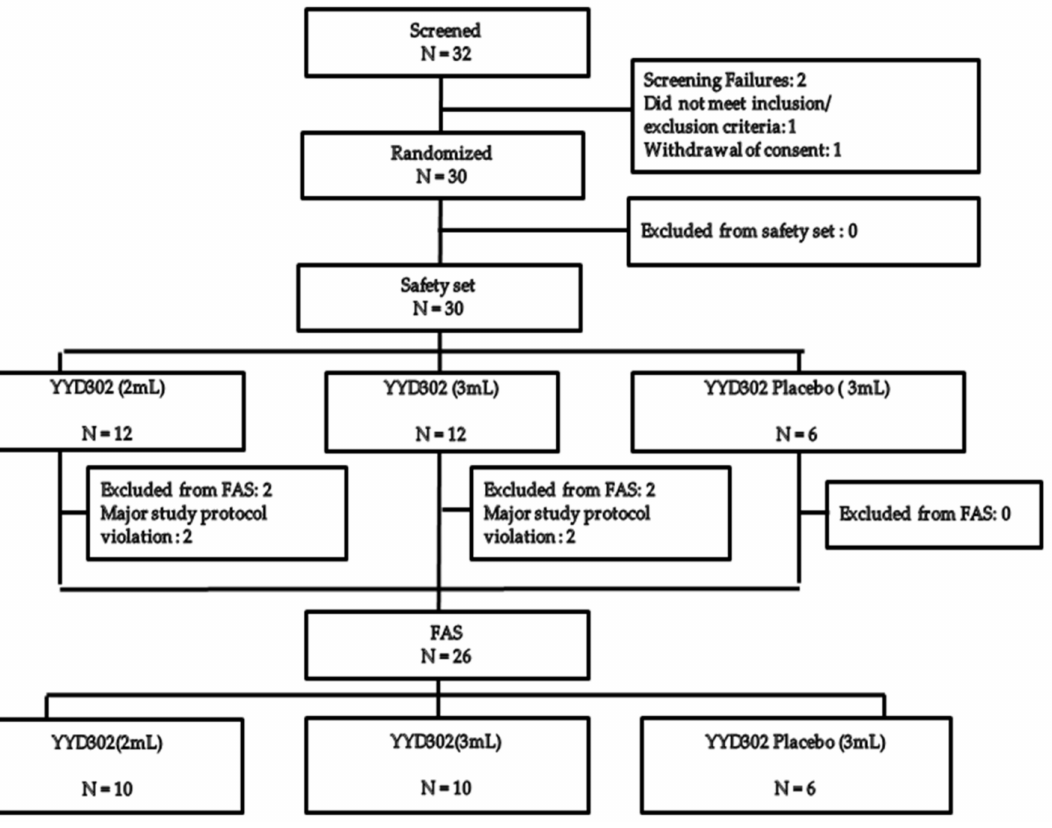
Figure 1. Subject